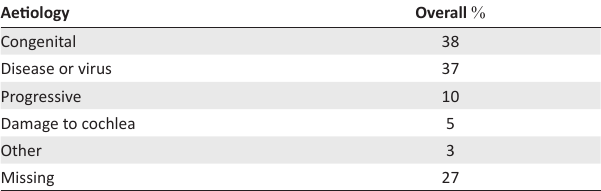
FIGURE 2: Post-operative hearing threshold levels